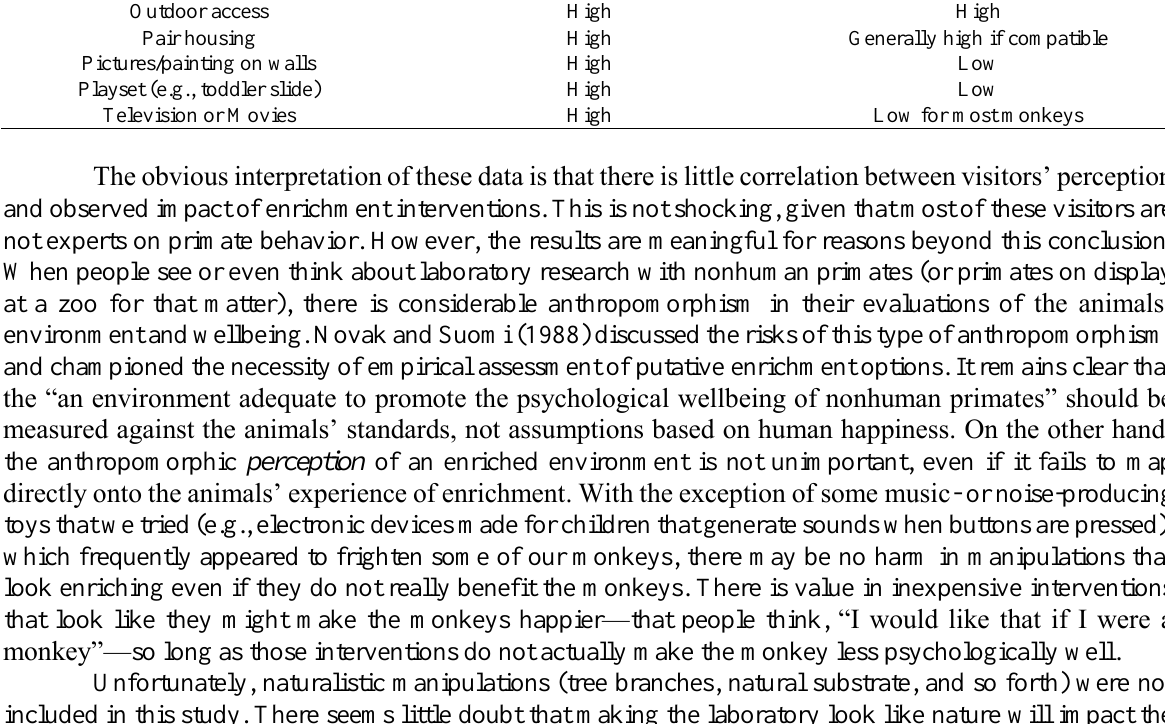
Perceived and Observed Enrichment Value of various Options Enrichment Option Perceived Impact Observed Impact Cage-size increase High Moderate or low Climbing/swinging structures High High for young monkeys Computer games High High Conspecifics in same room Moderate High Foraging toys (e.g., Kong ball) Low High when baited, low after Infant toys (e.g., rattles) Moderate High when novel, low after Menu options Low Moderate to high Mirrors Low to Moderate Low for most monkeys Music/radio High Low Musical/noisy toys High Low (with some neophobia) Outdoor access High High Pair housing High Generally high if compatible Pictures/painting on walls High Low Playset (e.g., toddler slide) High Low Television or Movies High Low for most